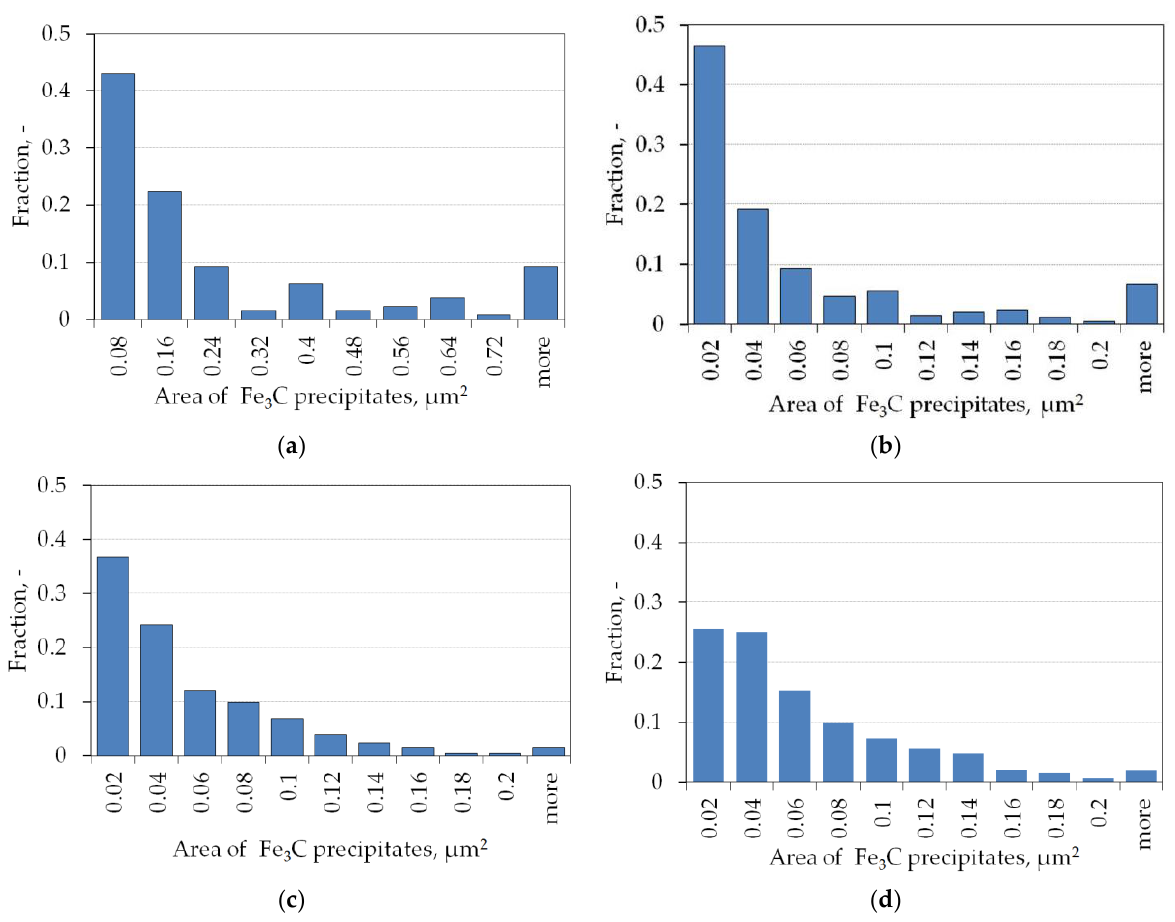
Figure 7. Distribution of the surface area of a flat section of Fe 3 C precipitates after deformation at 775 °C with a strain rate: ( a ) 0.001, ( b ) 0.01, ( c ) 0.1, ( d ) 1 s − 1 . Table 1. Characteristic of selected parameters of Fe 3 C particles.